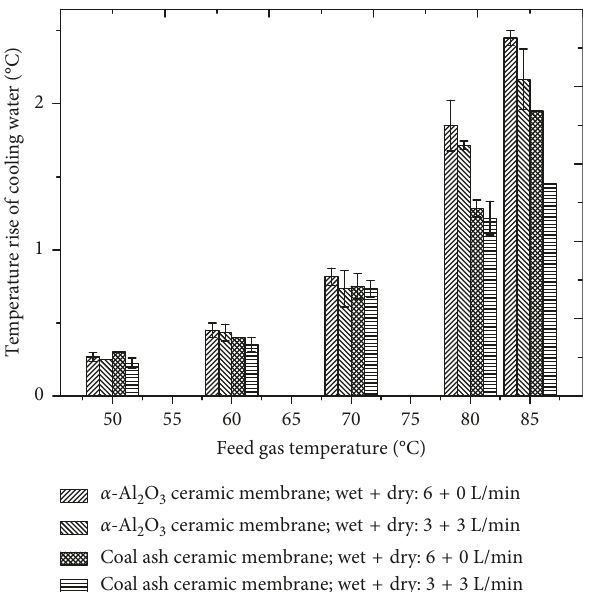
Figure 9: Comparison of temperature rise of cooling water be- tween the two membranes.